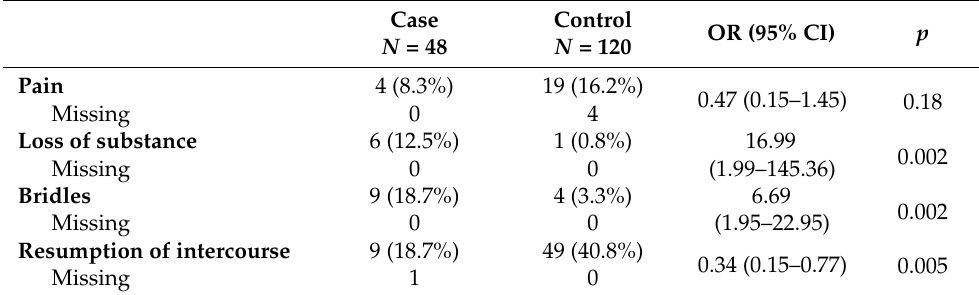
Table 4. Characteristics during the postnatal visit.